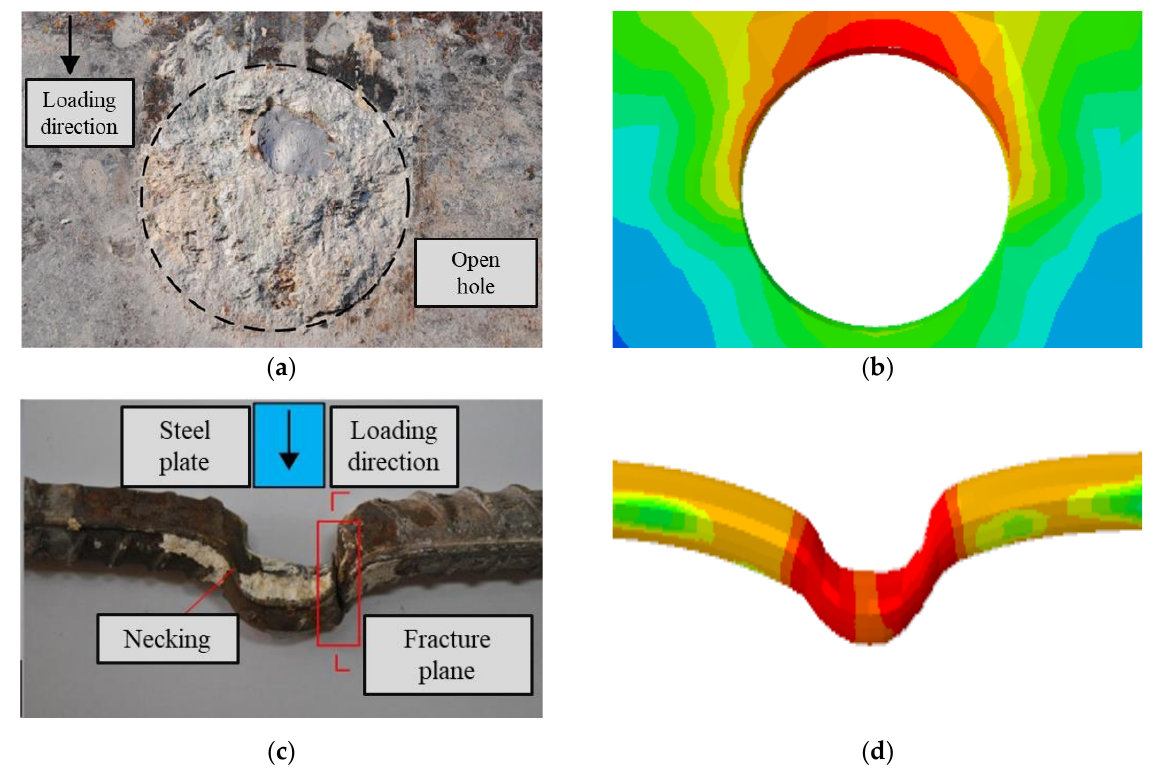
Figure 6. Comparison of damage patterns: ( a ) perforated steel plate (test), ( b ) perforated steel plate (FEA), ( c ) perforated rebar (test), ( d ) perforated rebar (FEA).